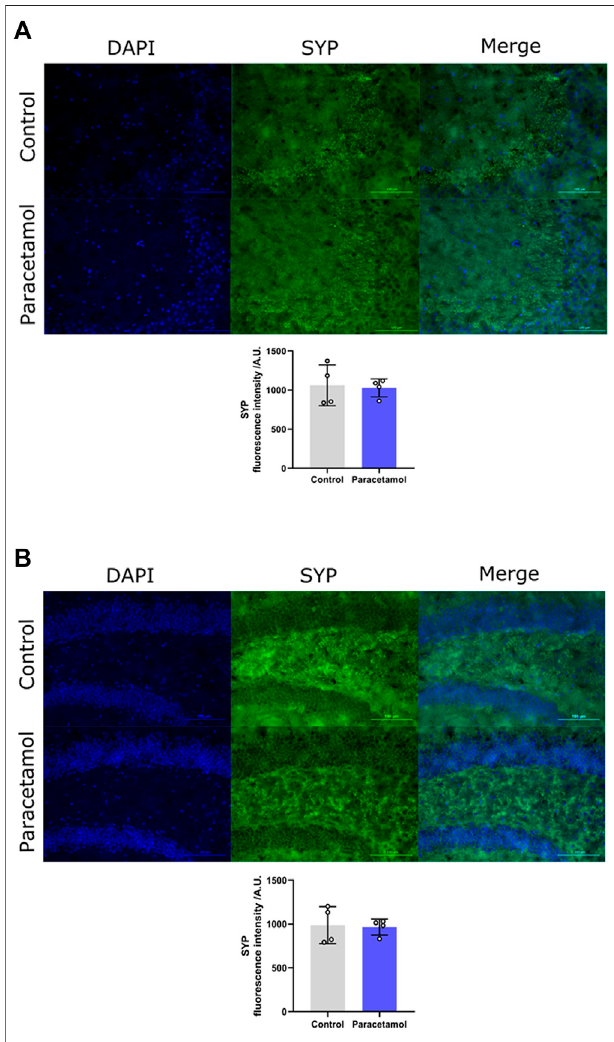
FIGURE 4 | Immuno fl uorescence staining of SYP in (A) CA3 and (B) DG coronal sections of the adult mouse hippocampus (Bregma − 1.94). Nucleic stainingwithDAPIaccompaniedbyimmunologicalstainingforSYP.Scalebar = 100 µm. Histogram show relative immuno fl uorescence intensity/A.U. of SYP measured in male adult mice after neonatal exposure to either saline vehicle or AAP on PND 10 in CA3 and DG. p > 0.05. The height of the bars represent mean value ±SEM. Each exposure group contained n = 4